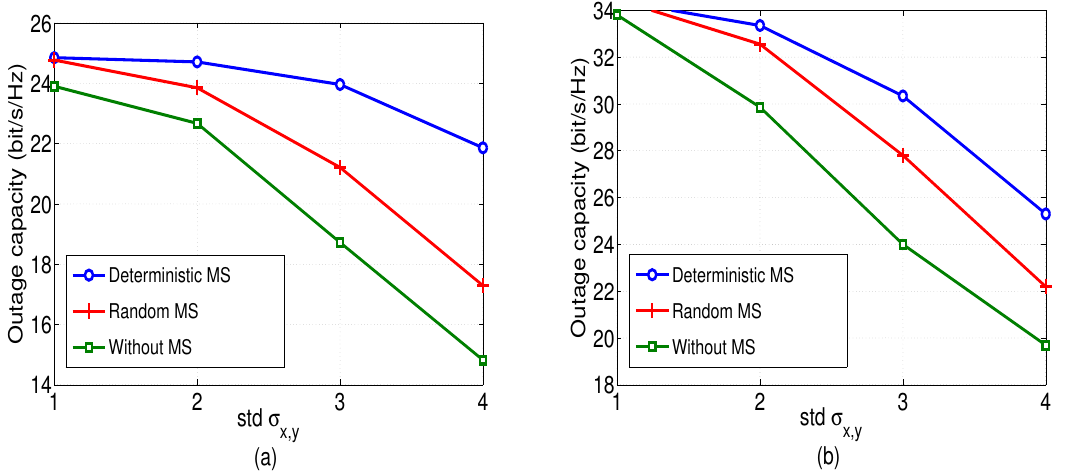
Figure 6. Outage capacities vs. misalignment std σ x , y for different scrambling strategies for SNR = 20 dB and an outage probability p out = 10 − 3 . ( a ) 6-mode fiber; ( b ) 10-mode